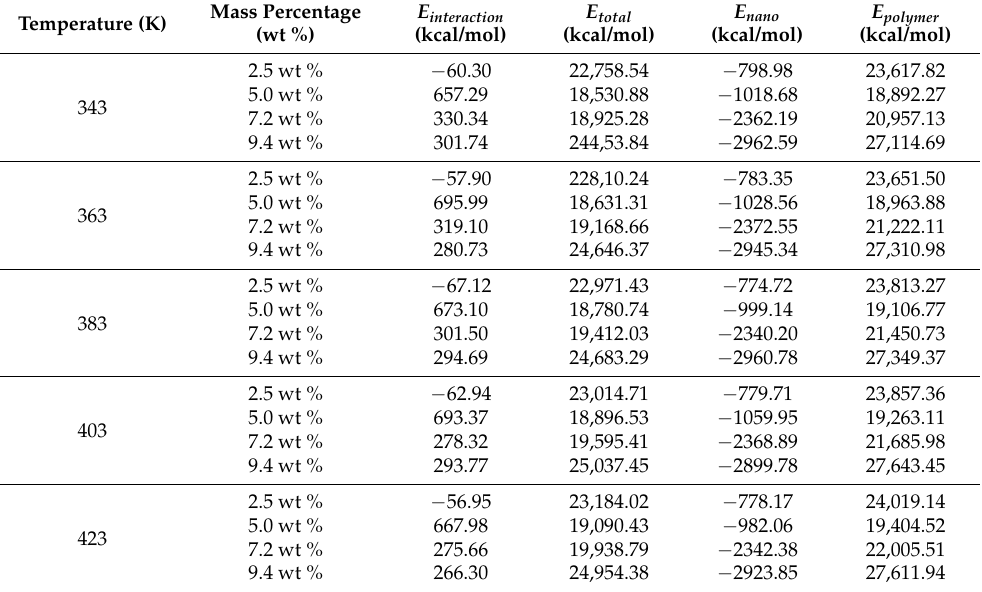
Table 3. Interaction energies of different polymethylsilsesquioxane (PMSQ) contents at different temperatures.